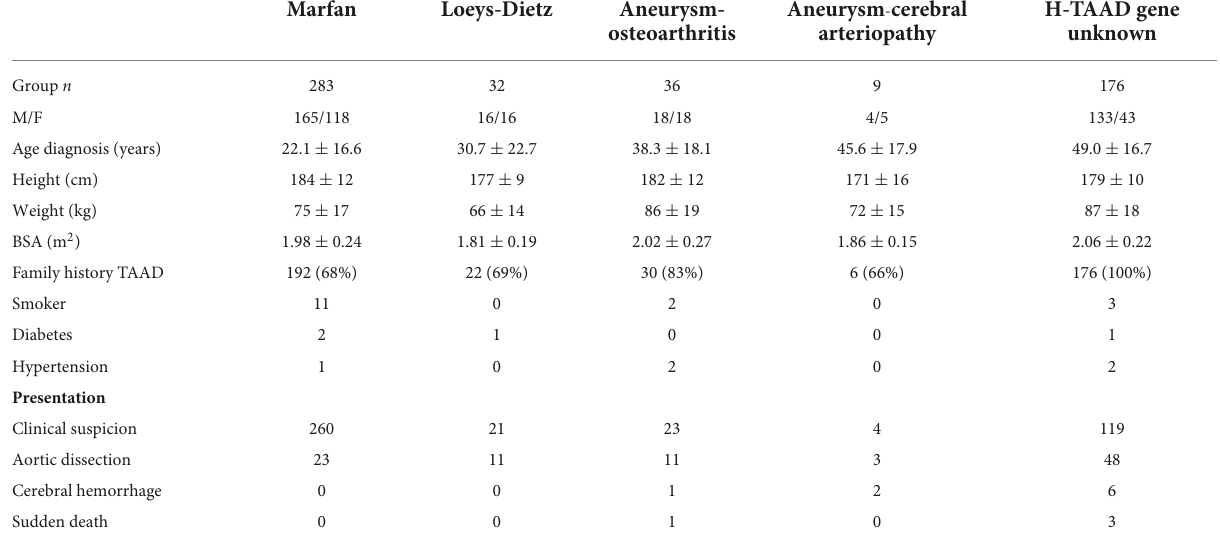
TABLE 1 Demographics of patient groups at